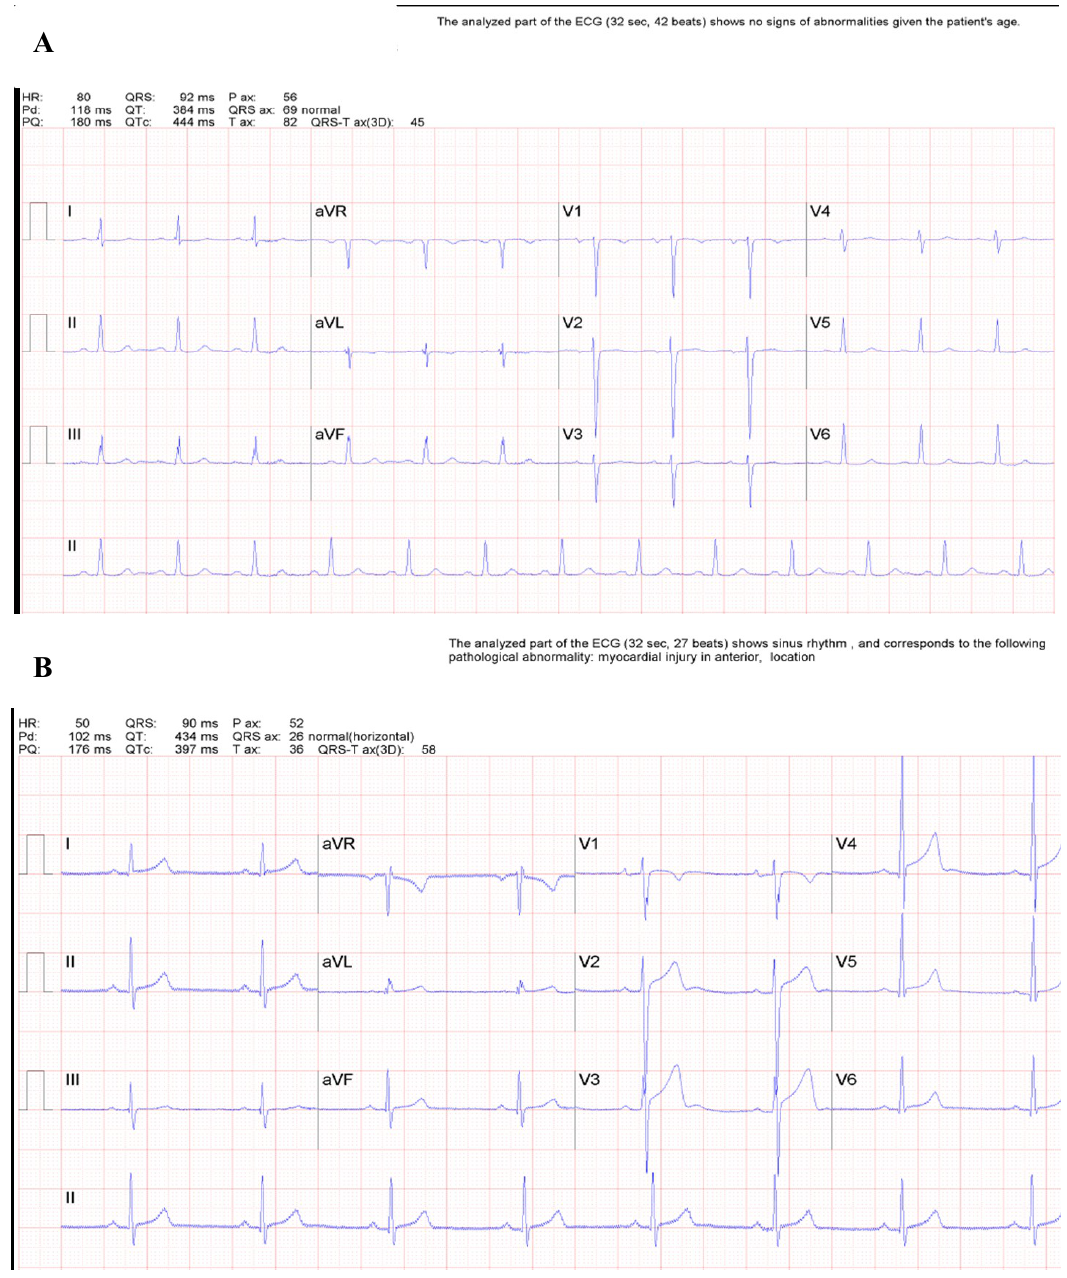
Figure 4. Additional Diagnostic Clarity Provided by Advanced ECG. ( A ) Conventional 12-lead ECG from a 57-year old male with imaging-proven non-ischemic cardiomyopathy and low left ventricular ejection fraction (25%). The conventional ECG software‘s automated interpretation, (see top of A ) is false negative in this case, even though poor R-wave progression is present; ( B ) Conventional 12-lead ECG from a 30-year old male triathlete, with a normal cardiac MRI. The conventional ECG software‘s automated interpretation (―myocardial injury in anterior location‖) is false positive in this case because the ST segment elevation present in some precordial leads is due to early repolarization, not ―myocardial injury‖; ( C ) Advanced-ECG-related linear discriminant analysis (DA) results from the same ECGs shown in ( A ) and ( B